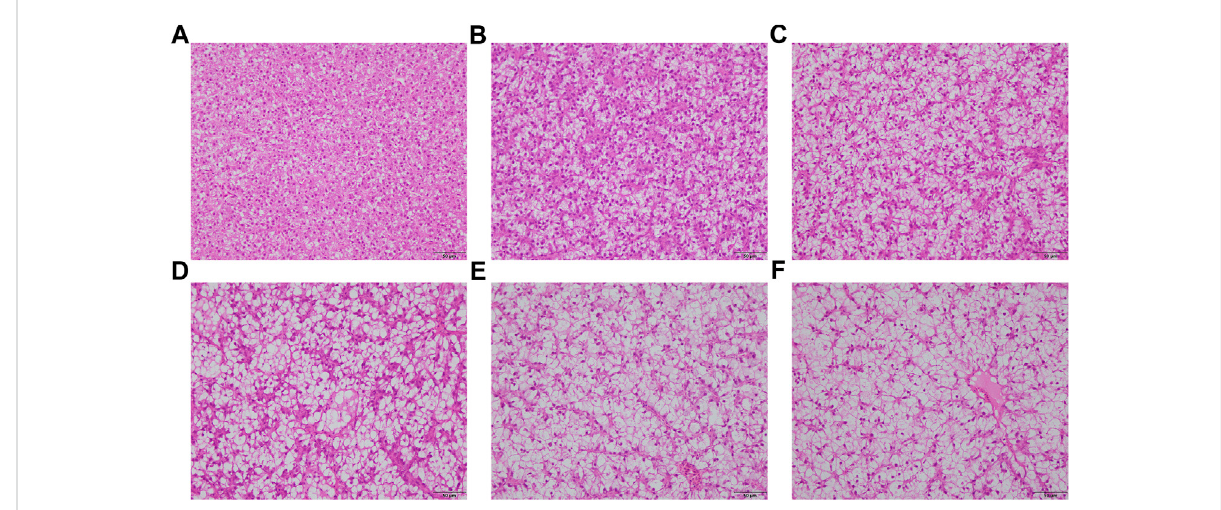
FIGURE 1 Representativeliversections(stainedbyhaematoxylinandeosin)ofjuvenileturbotfedwithdifferentdiets(Scalebars,50 μ m).CAM0 (A) wasthe control group, CAM15 (B) ,CAM30 (C) , CAM45 (D) ,CAM60 (E) andCAM80 (F) werereplacementgroupsformulatedbyreplacing 15%,30%,45%,60% and 80% fi sh meal in the control